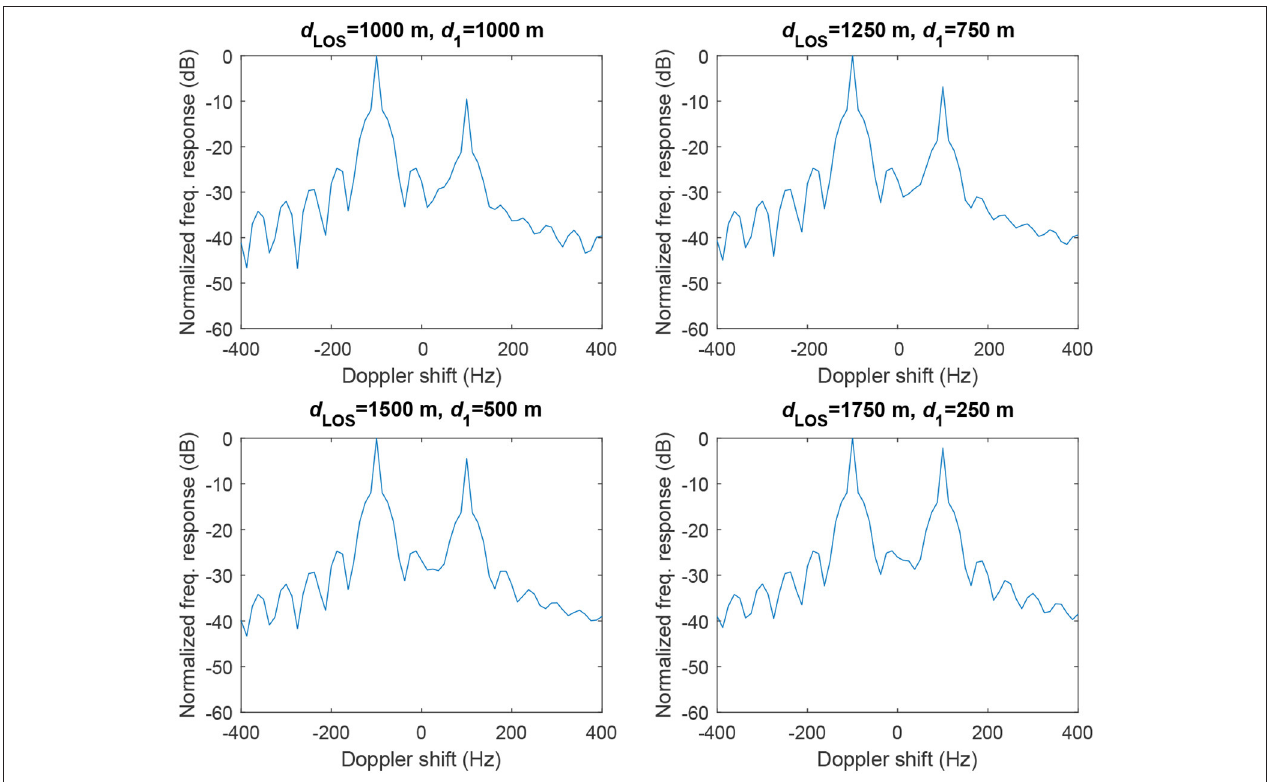
FIGURE 3 | Doppler spectrum of the received signal for varying d LOS and d 1 (FFT size: 256, sampling distance: λ/ 32 = 0.003125 m, sampling time: λ/ (32 × V ) = 0.3125